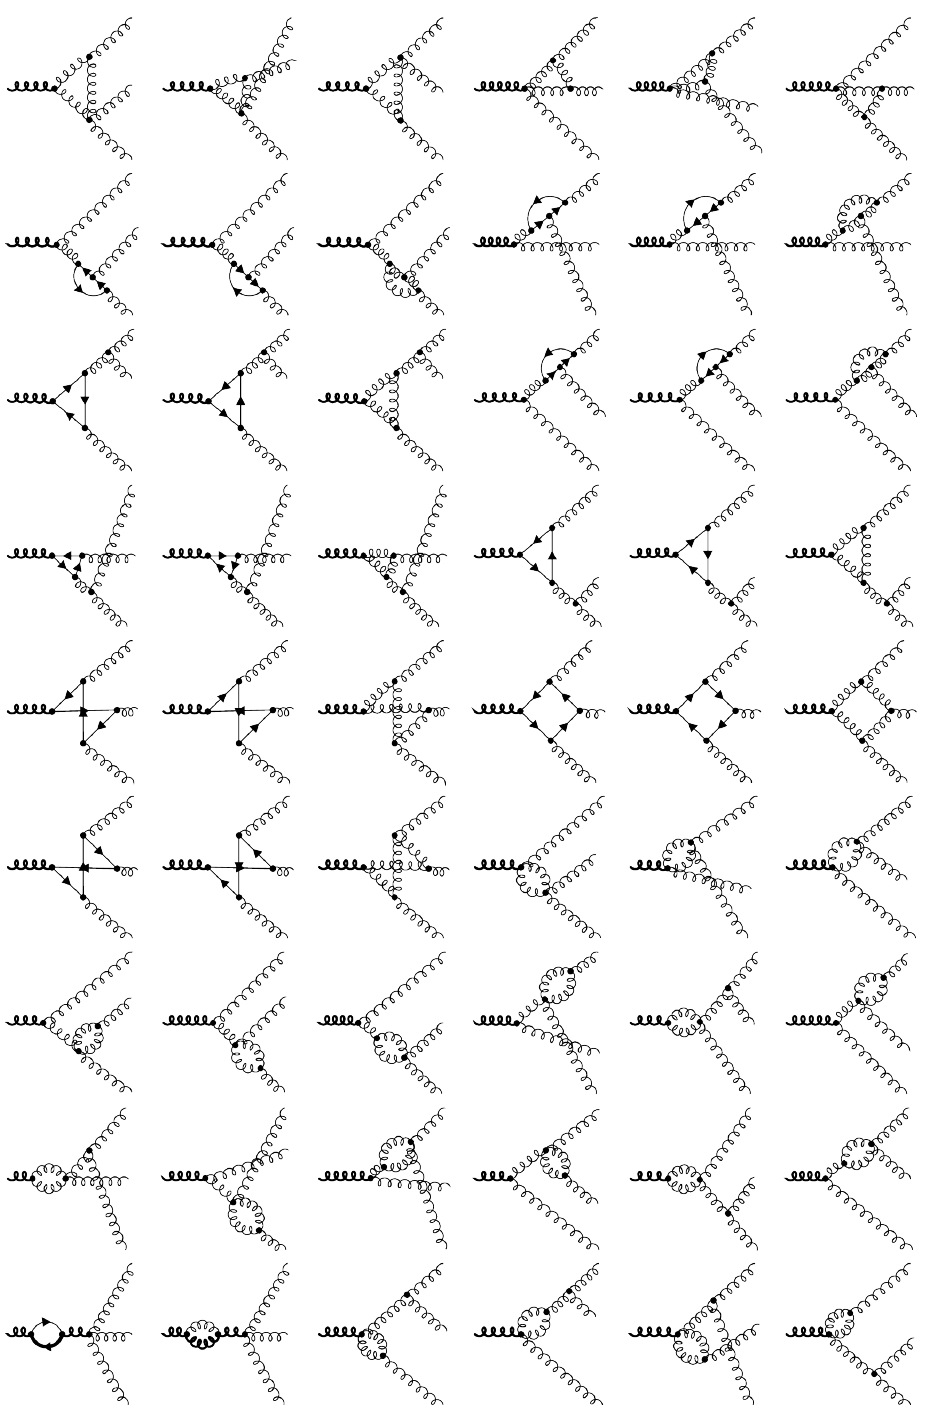
Figure 5 . Part of the 68 diagrams contributing to the splitting operator g → ggg . Description as in figure